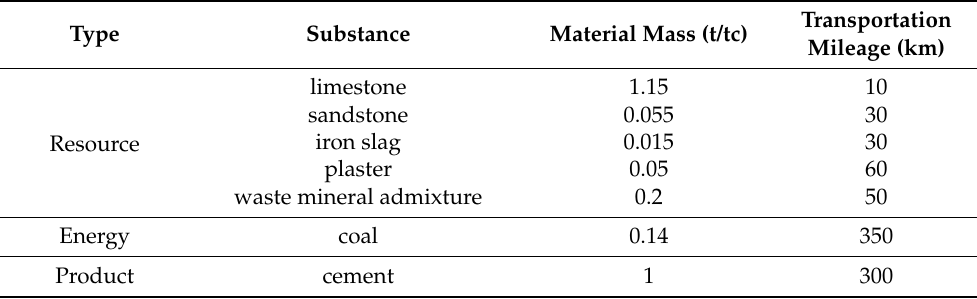
Table 6. Cement industry transportation substance